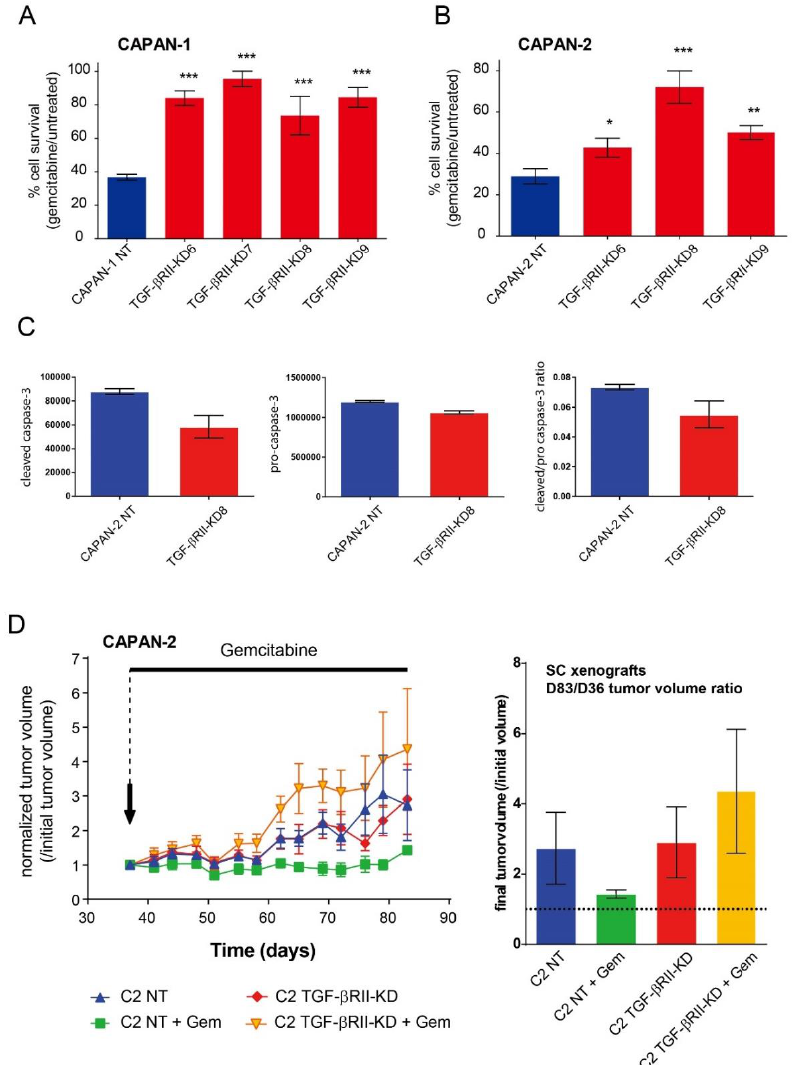
Figure 3. TGF- β RII alters sensitivity to gemcitabine in pancreatic cancer cells in vitro and in vivo. Survival rates in different TGF- β RII-KD CAPAN-1 ( A ) and CAPAN-2 ( B ) cell lines or their NT control cells were measured following treatment with gemcitabine using the MTT assay. Results are expressed as % of cell survival (/untreated cells). Three independent experiments were performed. ( C ) Pro and cleaved caspase-3 relative expression were analysed using Human Apoptosis Array Kit in TGF- β RII-KD CAPAN-2 cells following gemcitabine treatment. Cleaved/pro-caspase-3 ratio was calculated ( D ) Subcutaneous xenografts of NT and TGF- β RII-KD8 CAPAN-2 cells in SCID mice. Gemcitabine (15 mg/kg) or PBS (200 µ L) were injected intra-peritoneously, twice a week once palpable tumors were developed. Normalized tumor growth is expressed as the ratio of tumor progression relative to tumor volume on the first day of gemcitabine treatment. Right graph represents tumor growth over time. Left graph represents final tumor volume at day 83 (normalized as initial tumor volume at D36 equal to 1). * p < 0.05, ** p < 0.01 and *** p < 0.001 indicate statistical significance compared with the NT